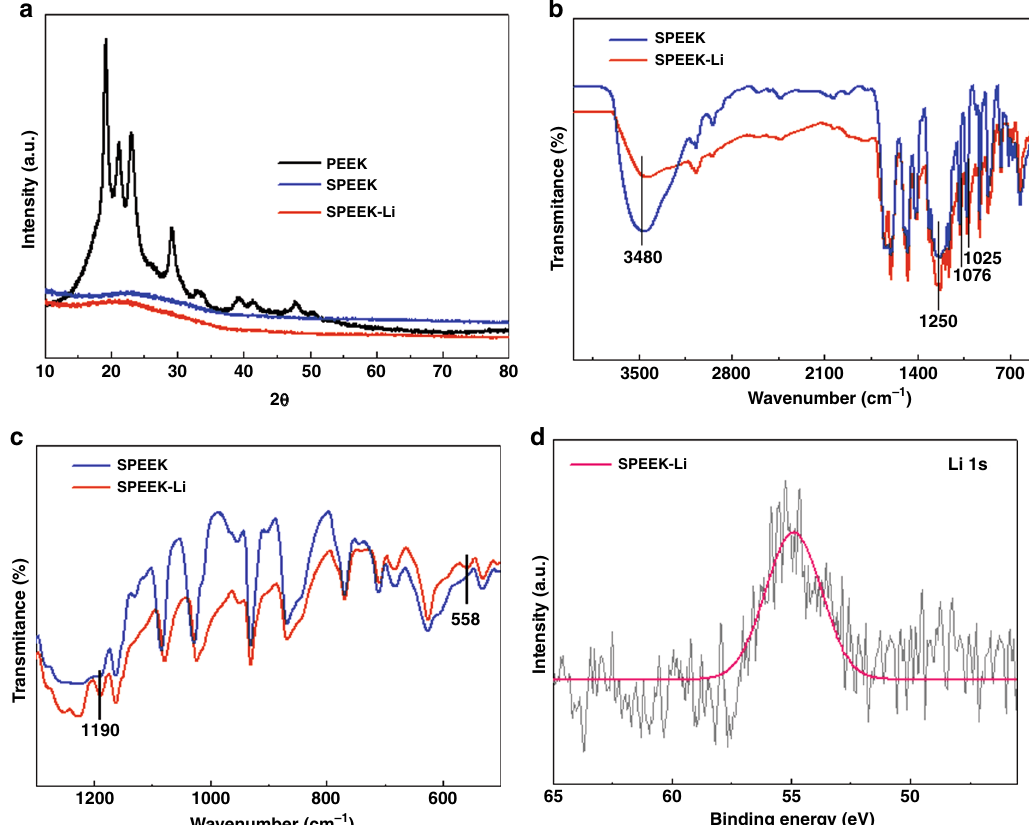
Fig. 2 Spectroscopic characterizations of SPEEK-Li. a XRD pattern; FTIR spectra of SPEEK and SPEEK-Li within different wavenumber ranges, b 4000 – 500 cm − 1 and c 1300 – 500 cm − 1 ; d XPS spectrum of Li in